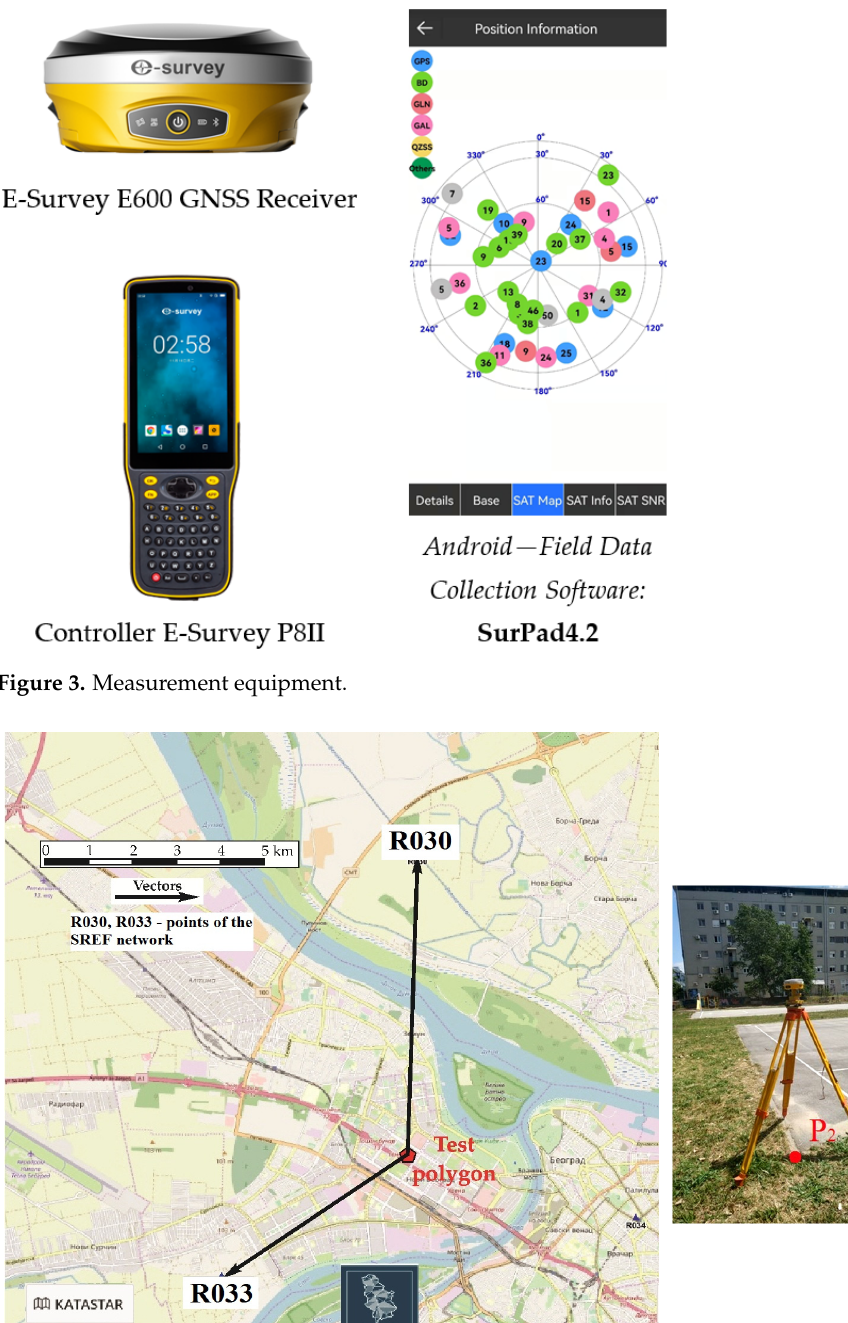
Figure 5. Measurements in the Test polygon—GNSS RTK mode (point P 1 of the Test polygon).